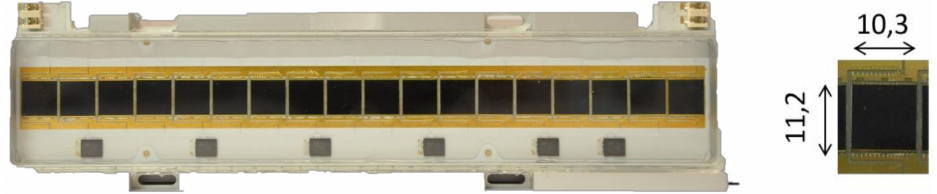
Figure 4. A photovoltaic module under test and a